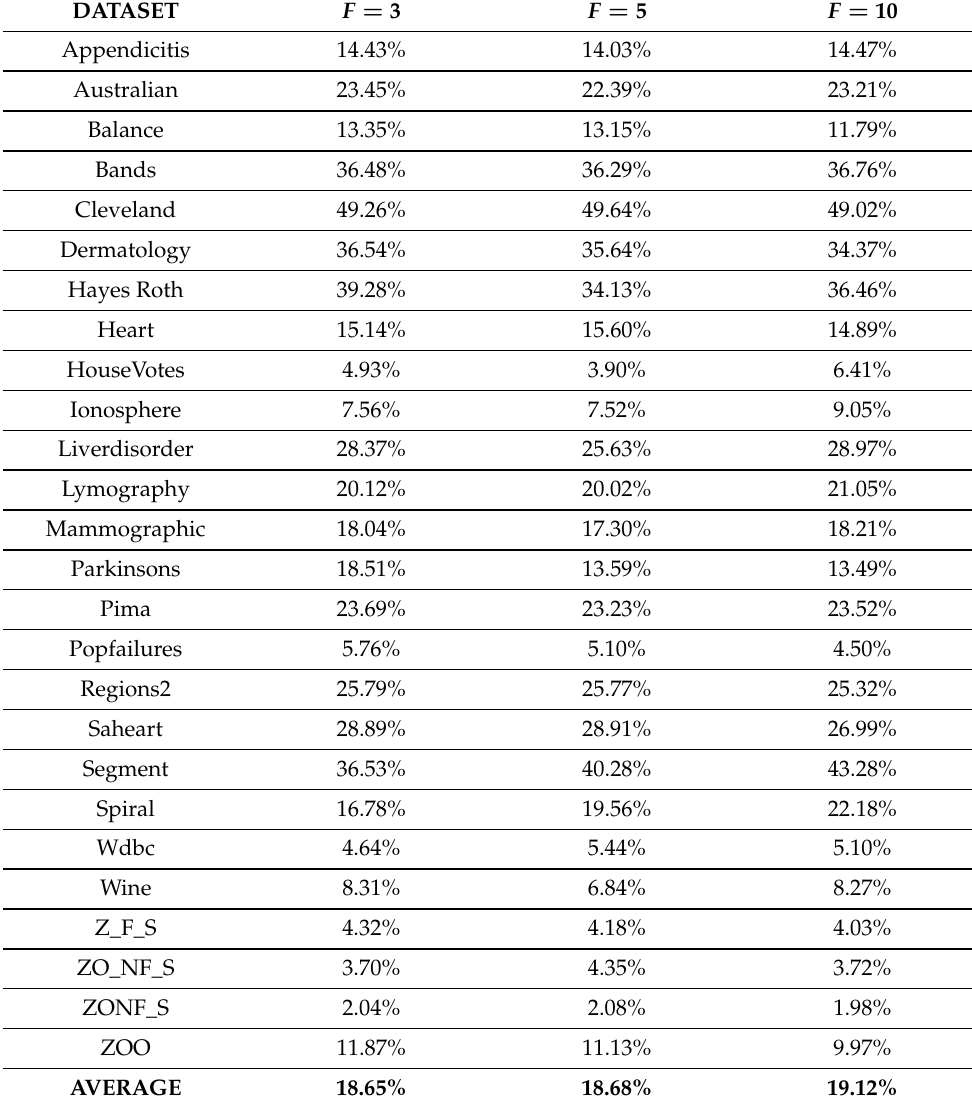
Table 4. Experimental results with the proposed method and using different values for the parameter F on the classification